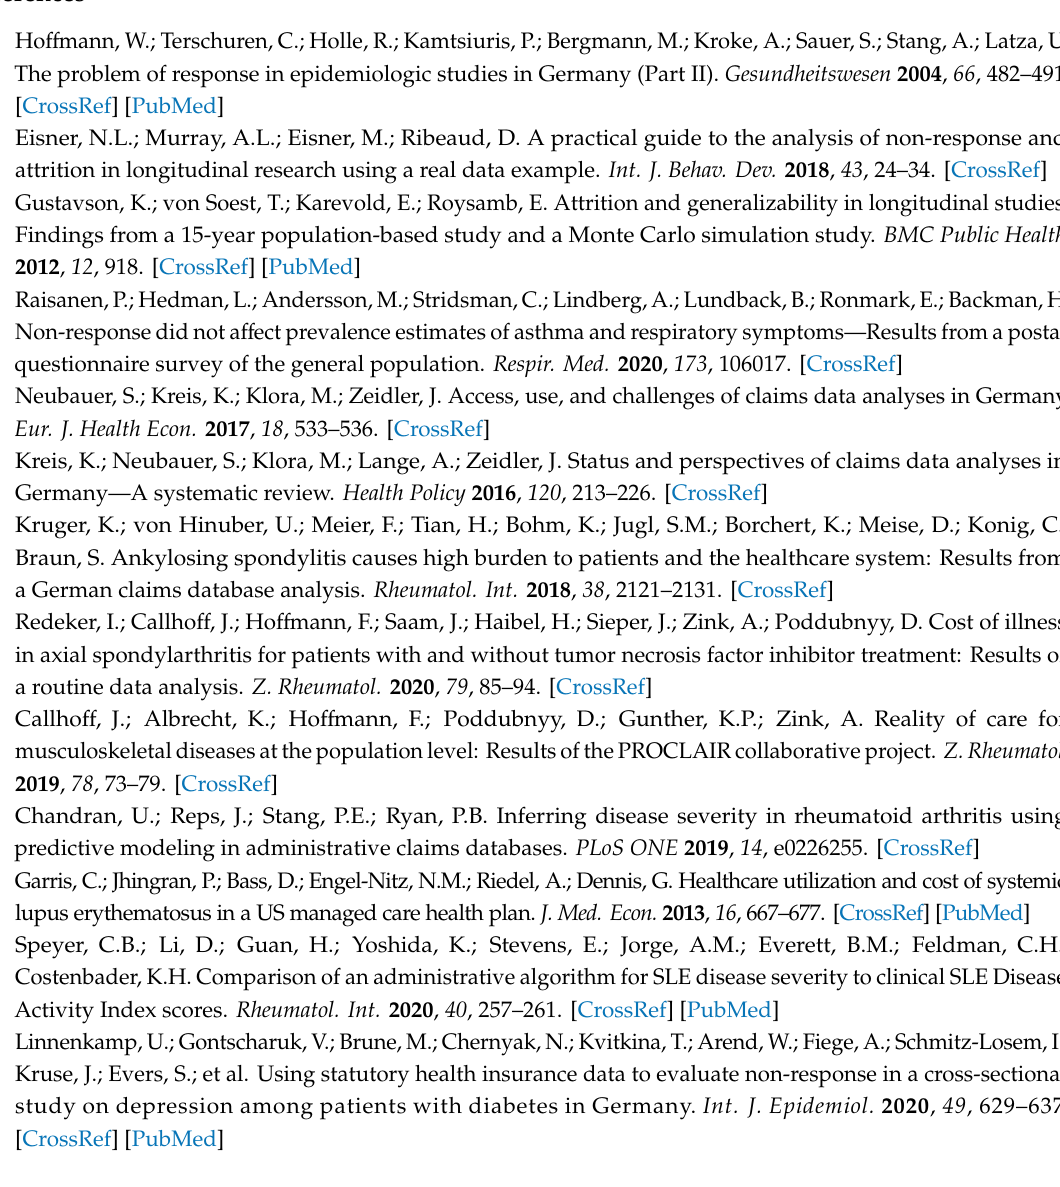
Table S1: Comparison of women and men in the age